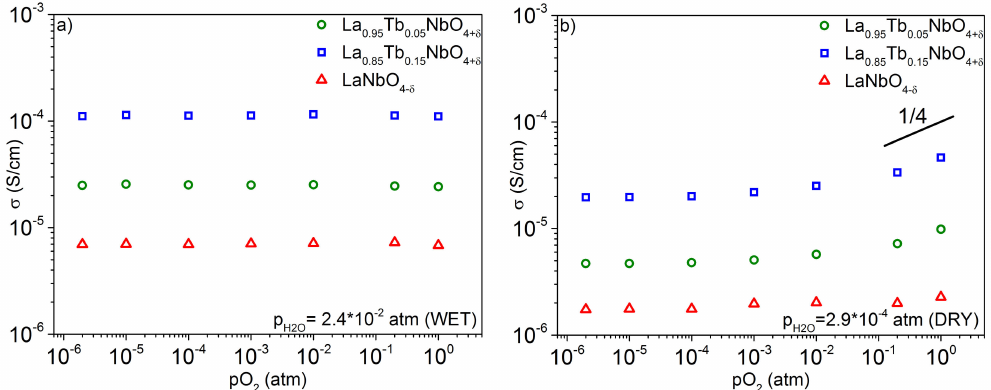
Figure 9. Total conductivity plotted as a function of pO 2 at 700 ◦ C of LaNbO 4 − δ , La 0.05 Tb 0.05 NbO 4+ δ , and La 0.15 Tb 0.85 NbO 4+ δ under ( a ) wet and ( b ) dry